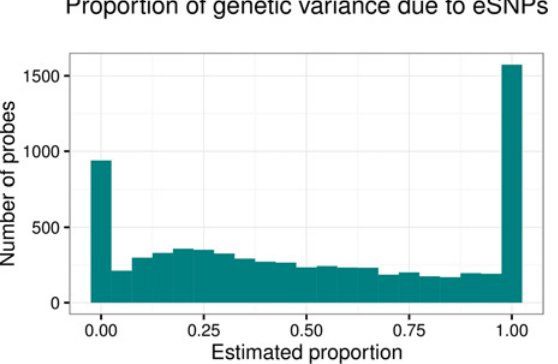
Fig 3. Distribution of proportion of genetic variance due to eSNPs. Proportion of genetic variance due to eSNPs (estimated as 1 — the ratio of the genetic variance component when eSNPs are included as fixed effects to the genetic variance component when eSNPs are not included) for the 7,280 heritable probes with local or distal associations, assuming values less than 0 (12%) are exactly